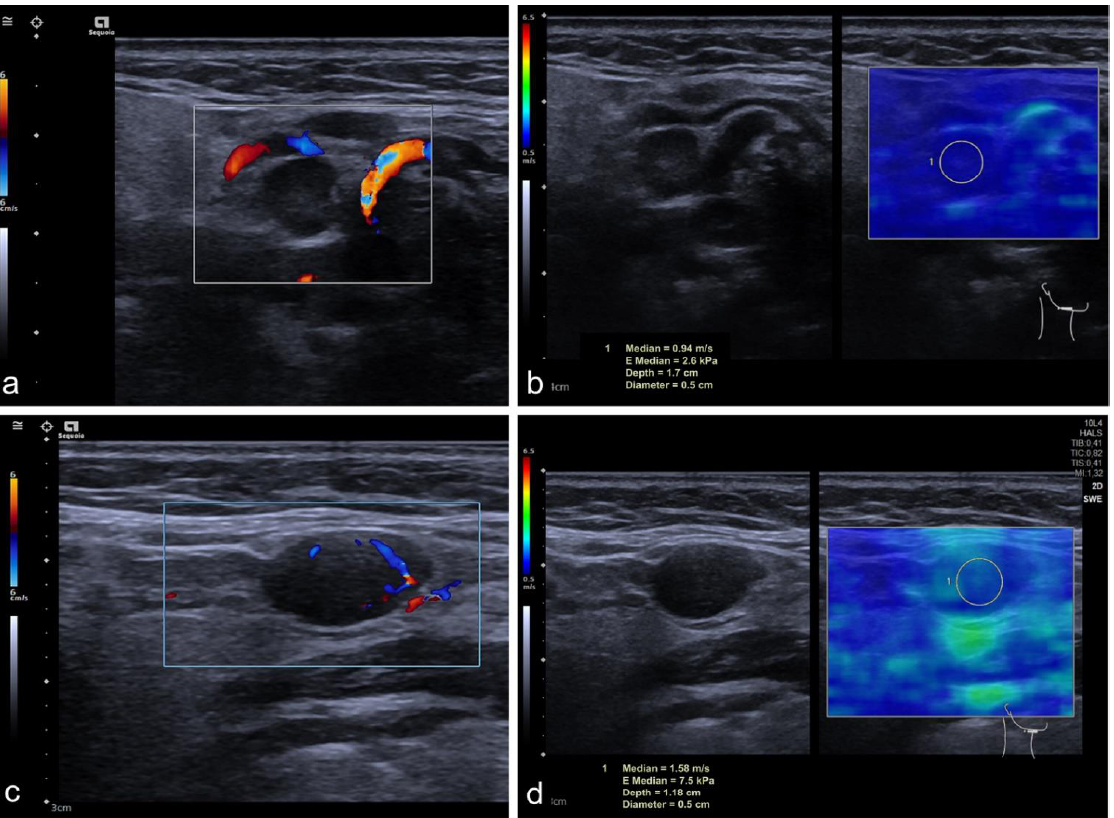
Figure 3. Inconclusive CLN on US and SWE. The figure demonstrates two cases of inconclusive CLN. Both CLN nodes were round shaped and represented decreased long-axis diameter combined with a Solbiati index < 2, thus indicating malignancy or inconclusive (Case 1: a , b ; Case 2: c , d ). The abnormal vascularization of color-coded duplex sonography is demonstrated as a non-parametric imaging marker (Figure 2a,c). Both CLN presented low stiffness on SWE as demonstrated in Figure 2b for Case 1 (0.94 m/s) and Case 2 in Figure 2d (1.48 m/s), despite their abnormalities on non-enhanced US ( b , d ).